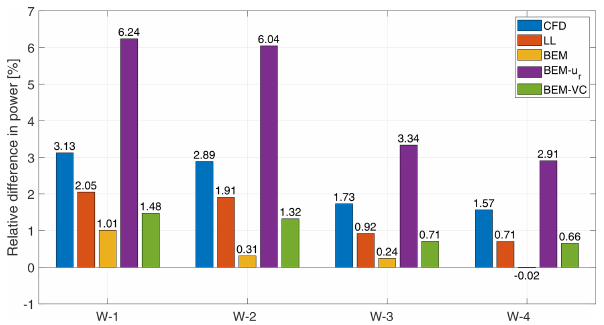
Figure 18. The relative difference of thrust of the dihedral blades without cone compared to the baseline straight blade. The opera- tional condition is with a uniform wind speed of 8ms − 1 , rotational speed of 0.855rads − 1 and zero cone